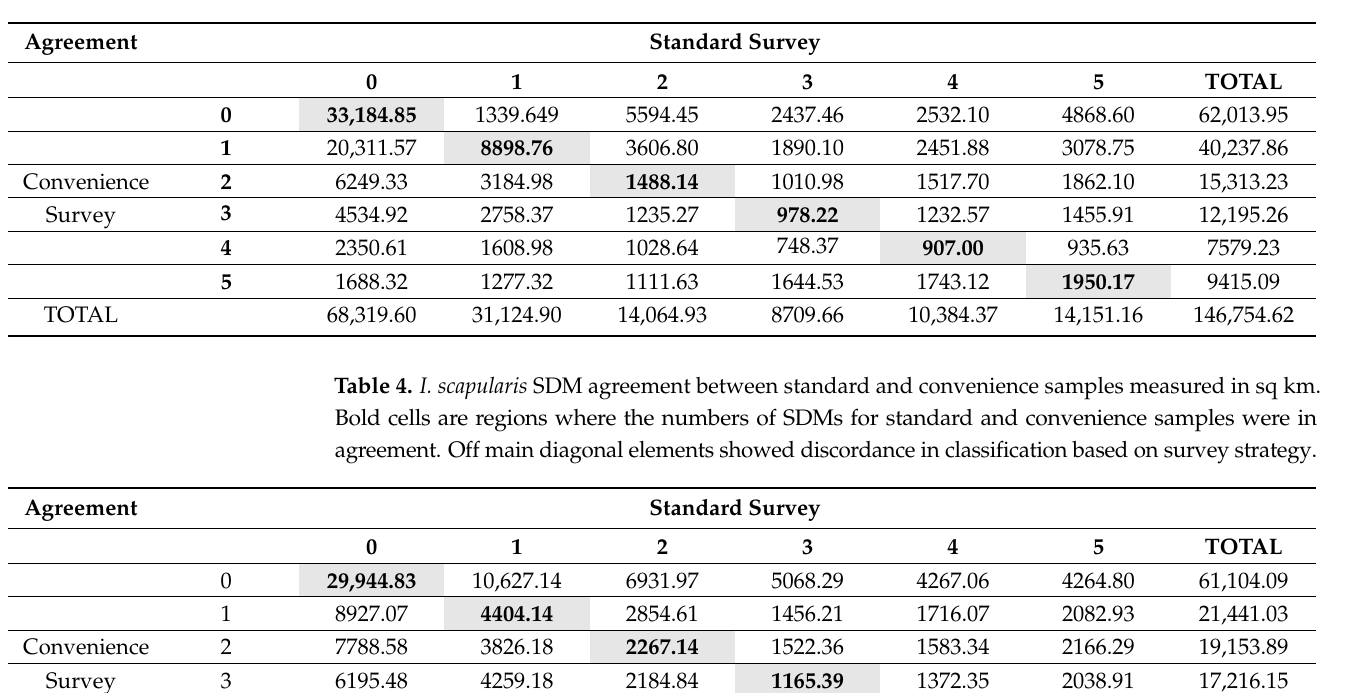
Table 3. A. americanum SDM agreement between standard and convenience samples measured in sq km. Bolded cells are regions where the numbers of SDMs for standard and convenience surveys were in agreement. Off main diagonal elements showed discordance in classification based on survey strategy.